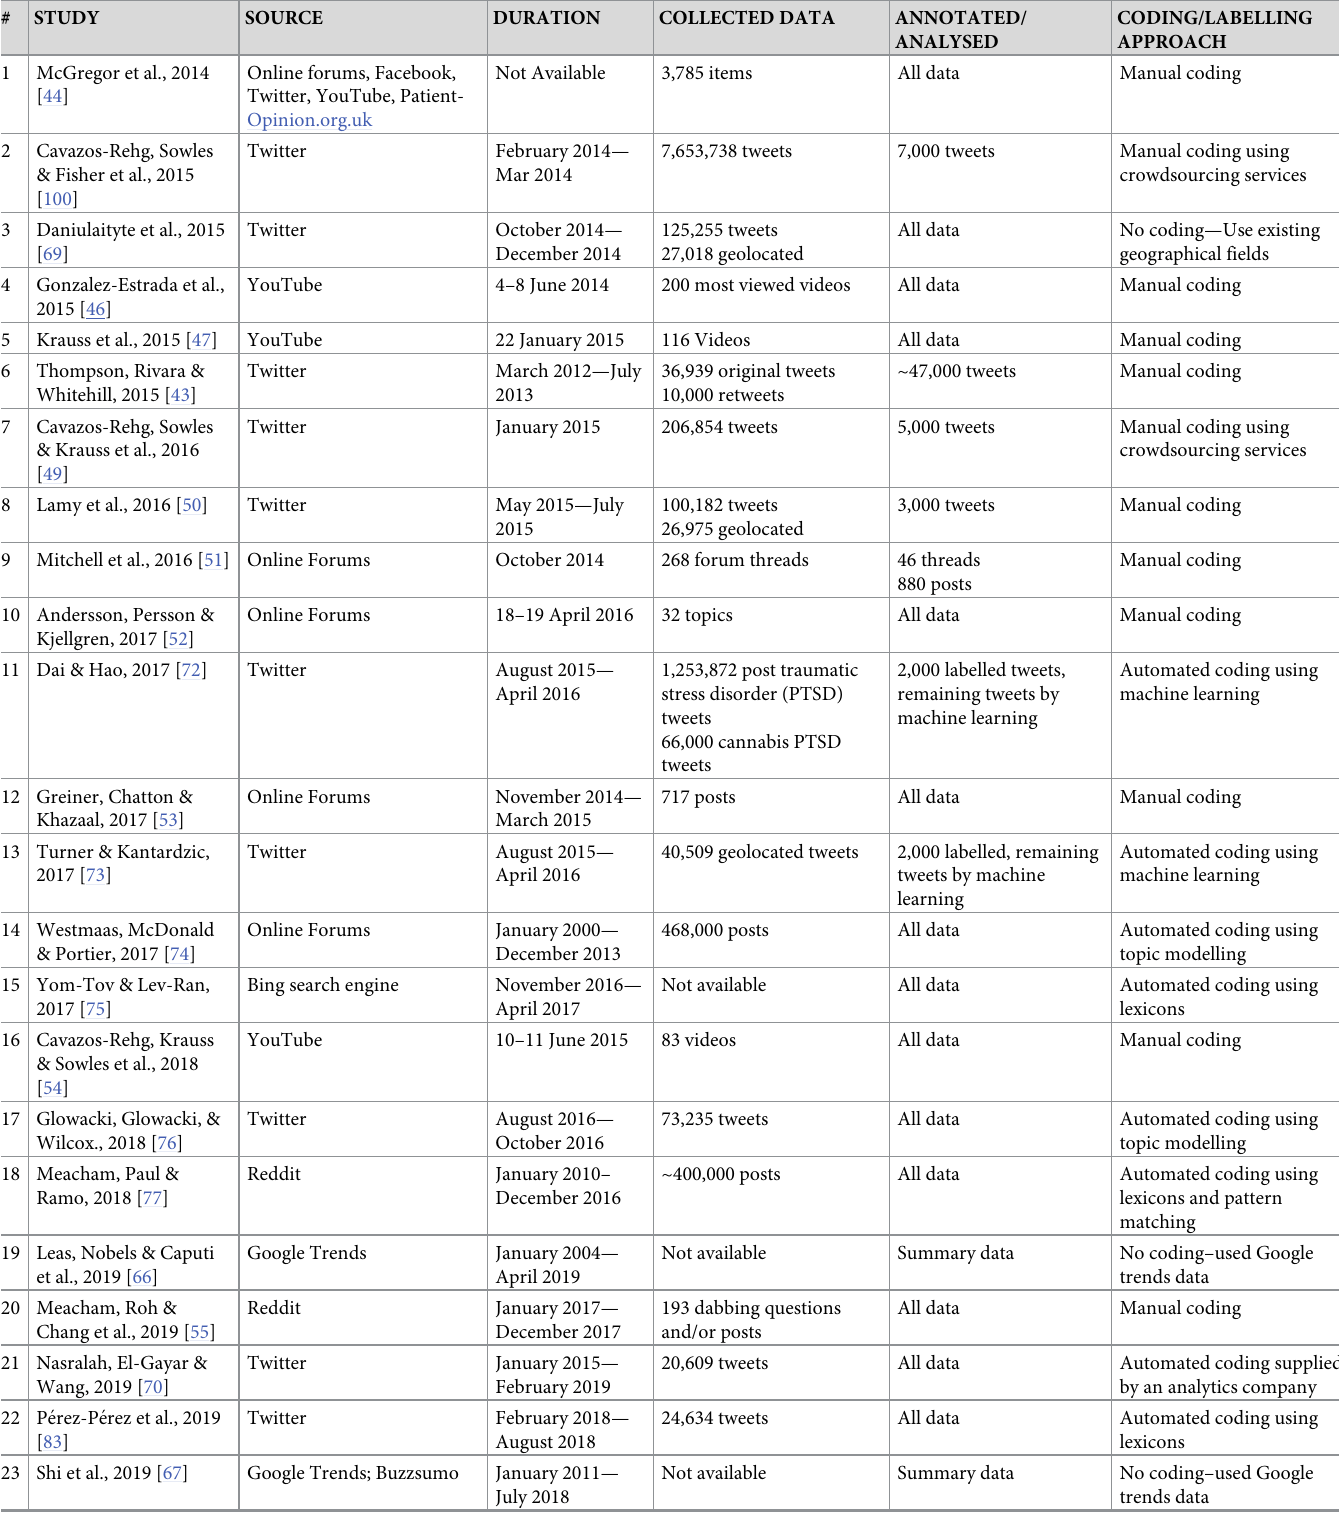
Table 2. Articles included in the